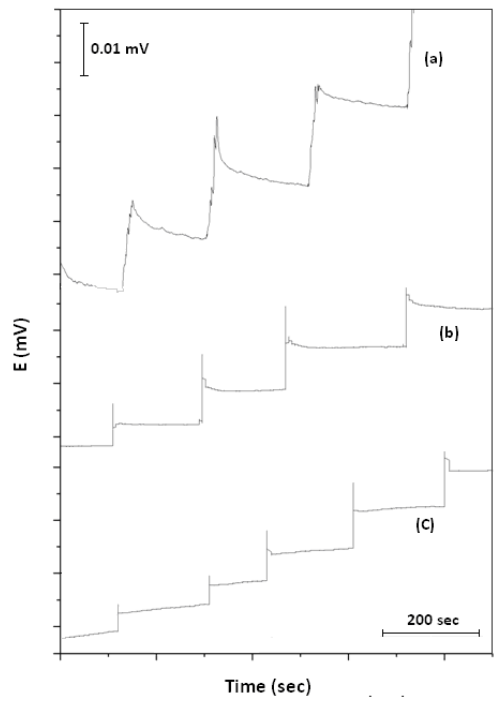
Figure 3. Kinetic response of the three ion-selective membranes tested; ( a ) PVC; ( b ) PEG; and ( c ) PEDOT after HCl